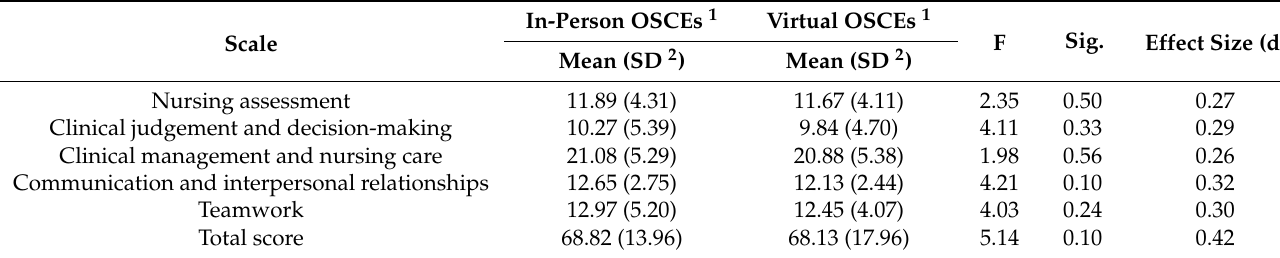
Table 3. Descriptive data, t -test, and effect sizes (d) of differences between in-person OSCEs and virtual OSCEs for each competence category of checklists and its total